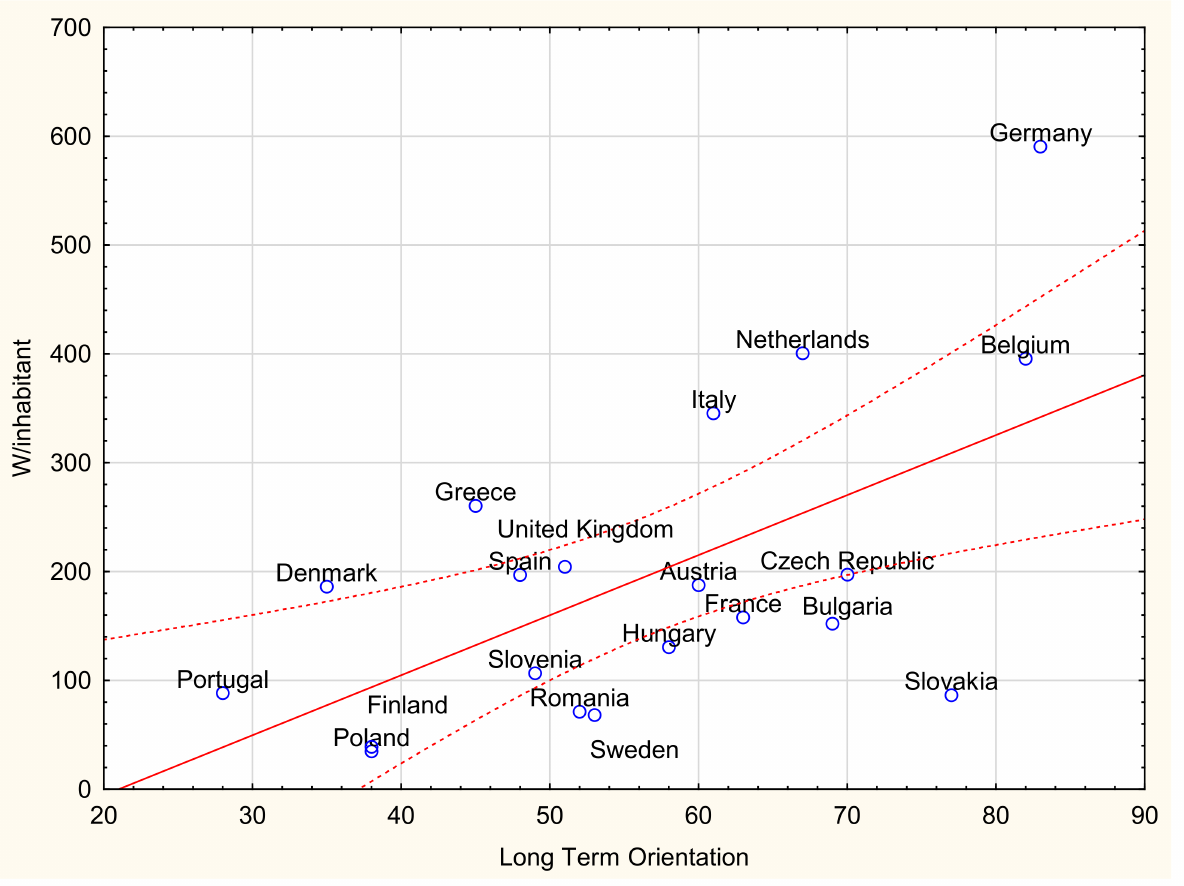
Figure 8. Relationship between long-term orientation of the country and W/inhabitant of photo- voltaic capacity. Source: Authors’ own